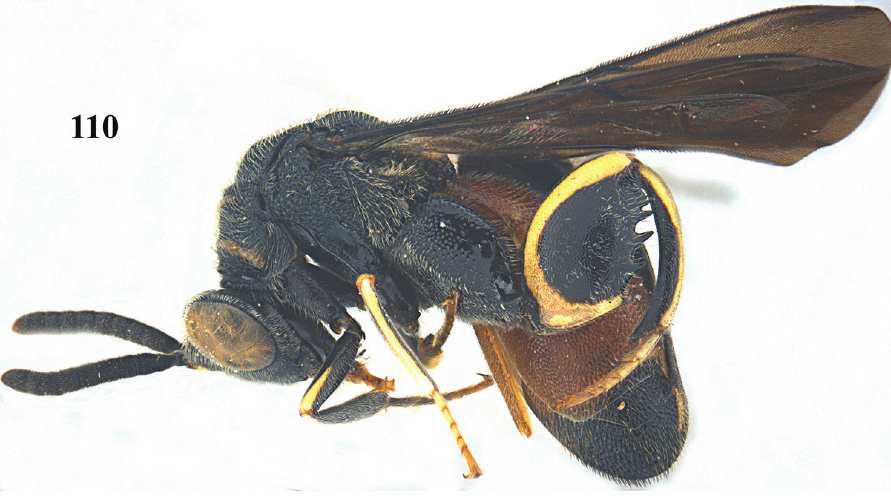
Leucospis petiolata Fabricius,